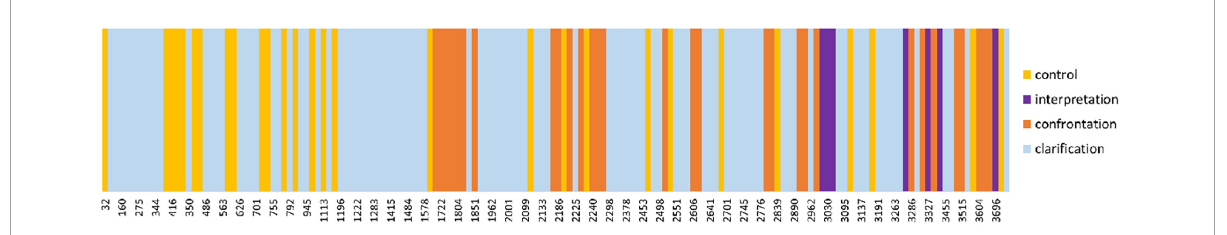
FIGURE1 X-axis of the graphs shows the starting points with the color-coded conditions during the interview. Yellow, control; light blue, clarification; orange, confrontation; and violet,